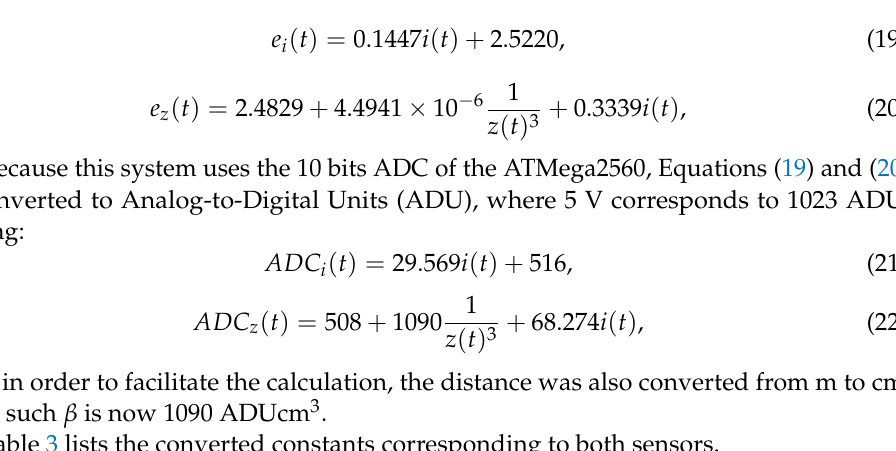
Table 3 lists the converted constants corresponding to both sensors. Table 3. Sensors constants.